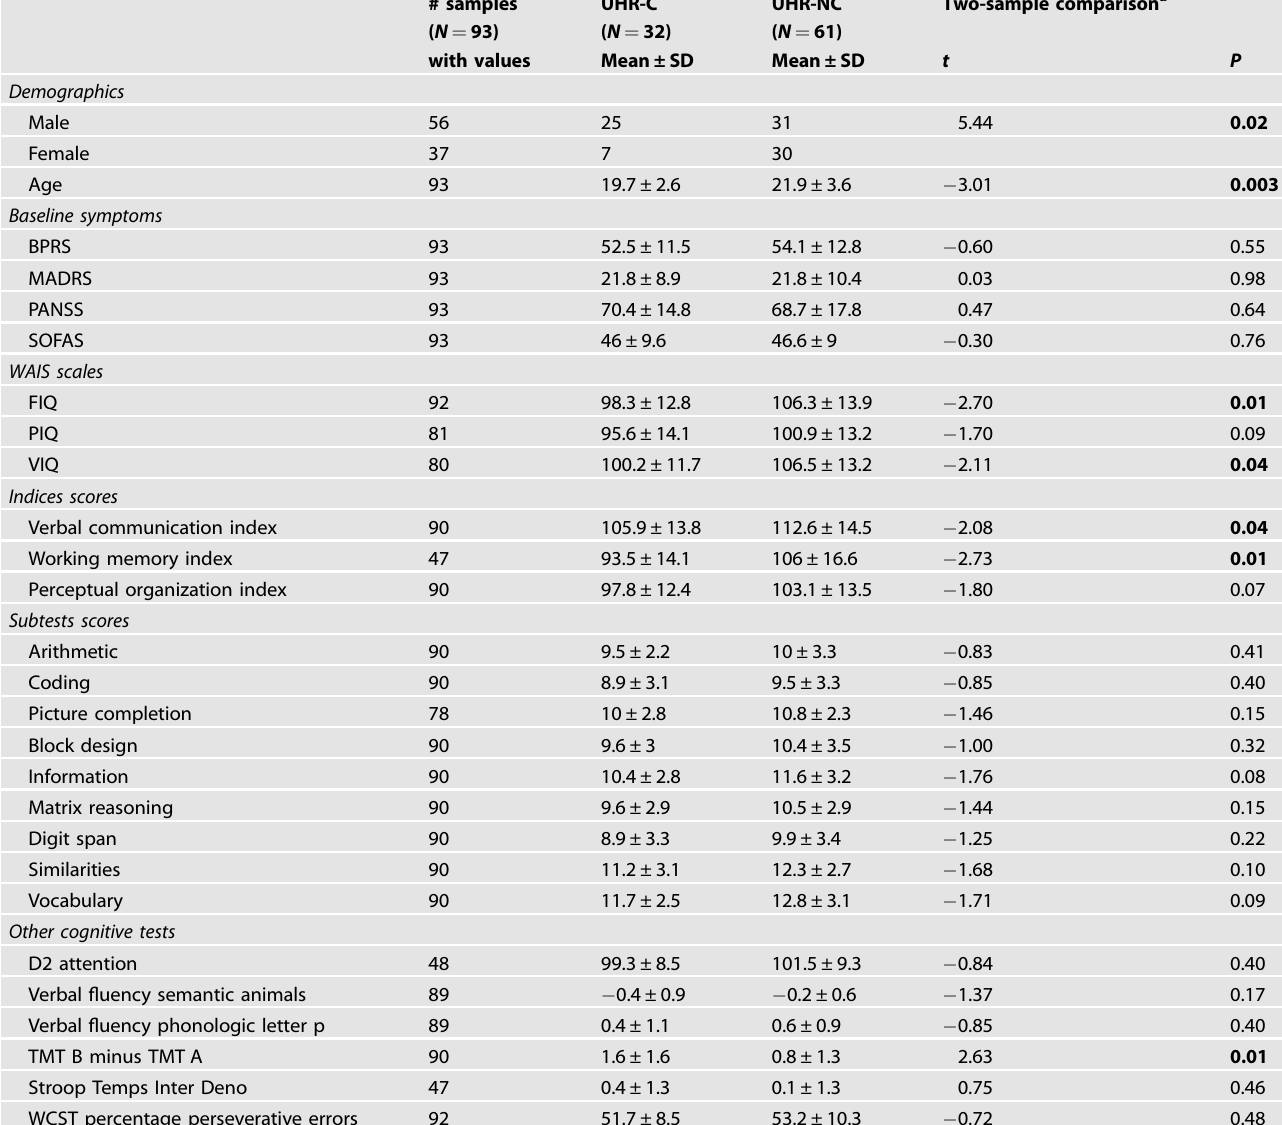
Table 1. Summary statistics of the cognitive tests in the UHR samples by conversion status.